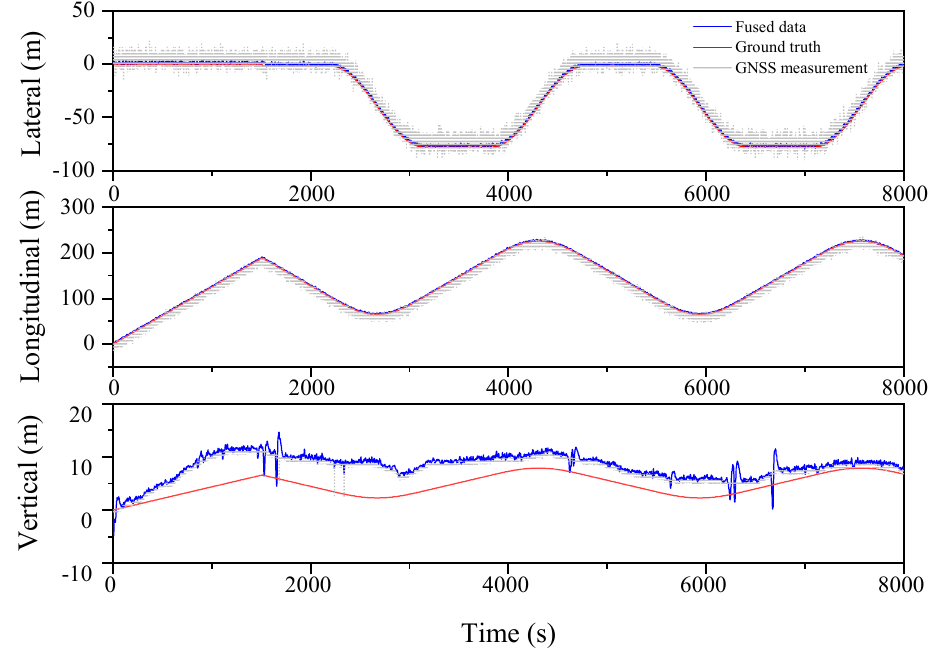
Figure 3. Lateral, Longitudinal and Vertical positions of EKF (Oval).